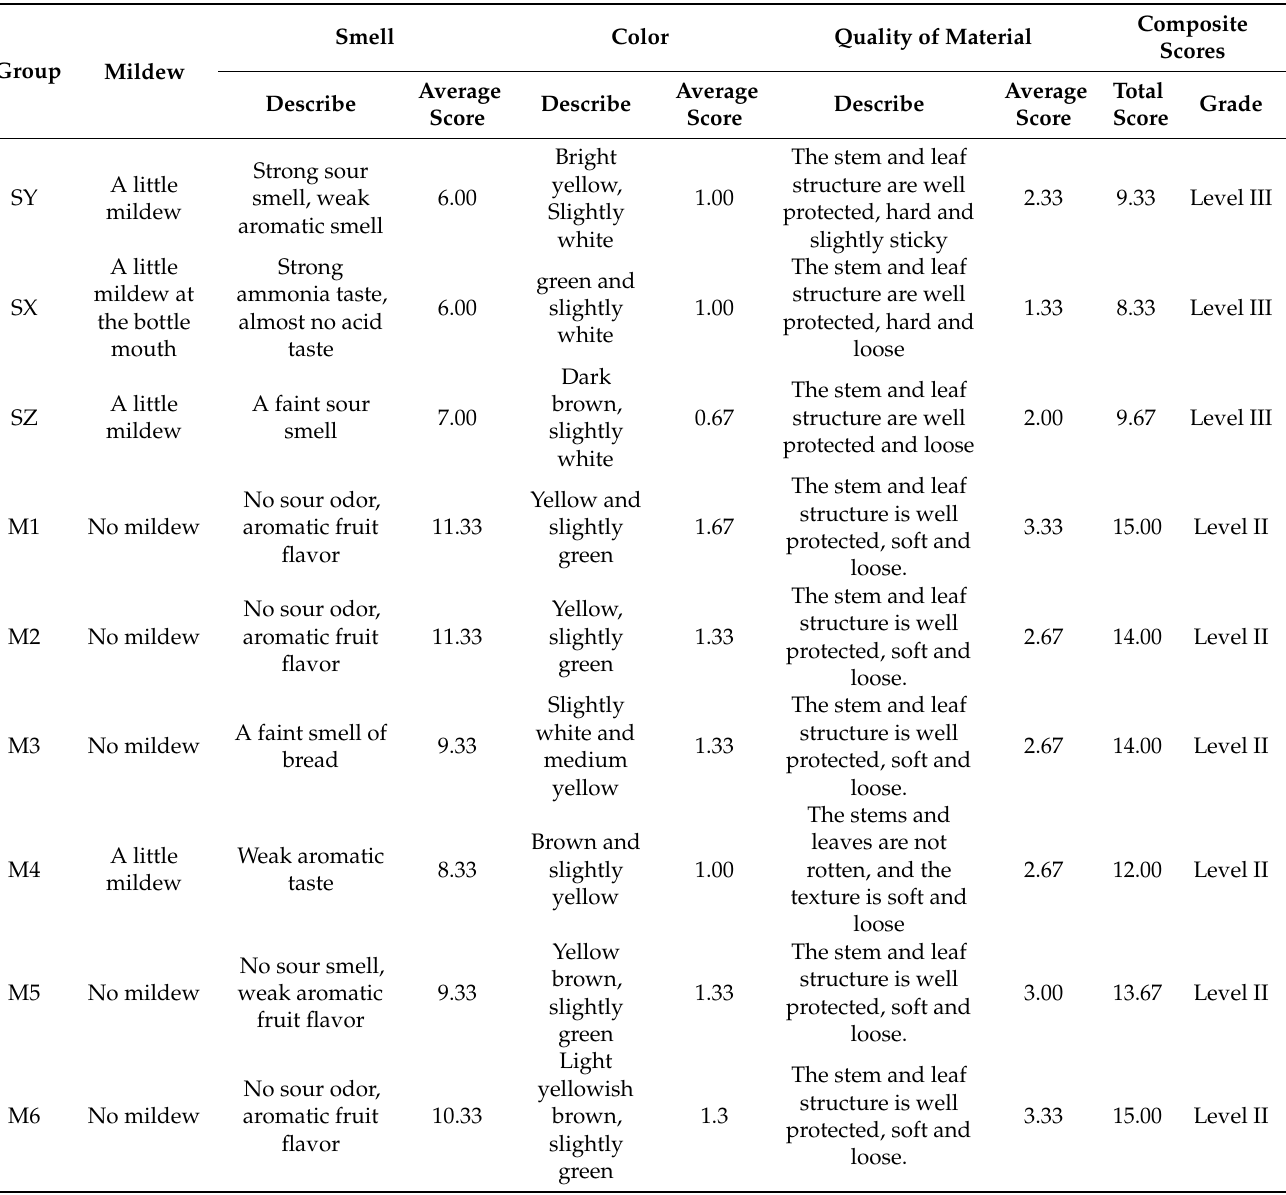
Table 5. Sensory evaluation of mixed silage after the cans were